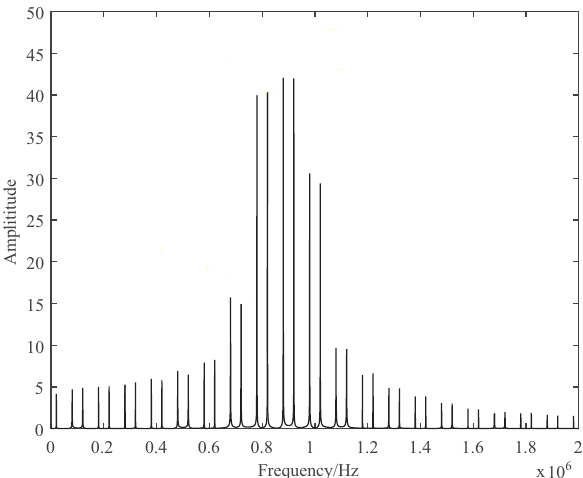
Figure 3. Discrete-spectrum of beat frequency signal with F m = 100